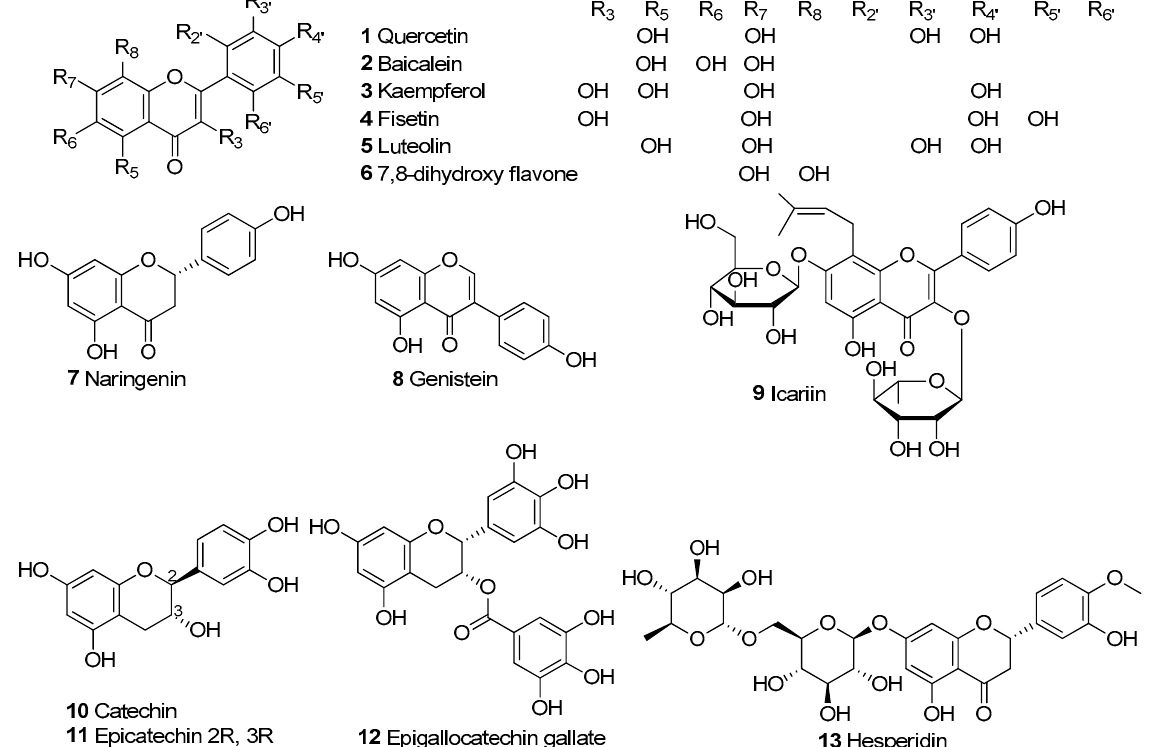
Figure 3. Chemical structures of flavonoids.